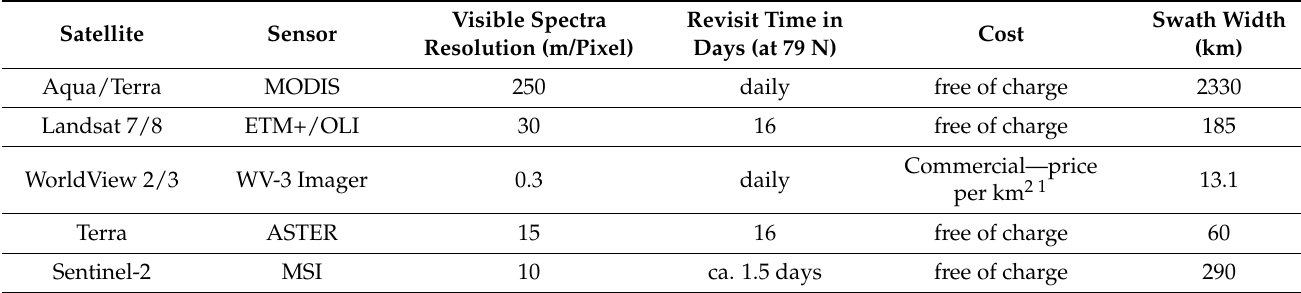
Table 1. Multispectral sensors employed in previous studies of supraglacial lakes (SGL) on Greenland.